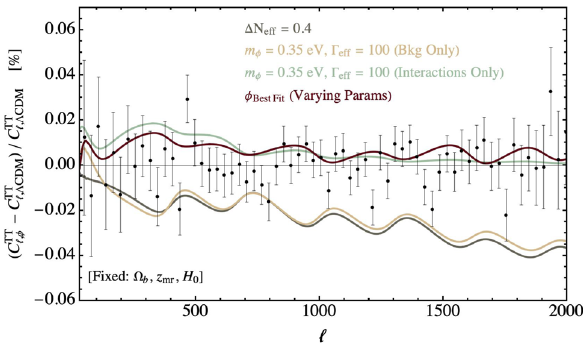
Fig. 5 Relative difference between TT power spectrum compared in various models and that of (cid:3) CDM, shown in comparison with Planck 2018 residuals. Models shown include (i) constant (cid:2) N eff = 0 . 4 (grey), ≡ 0 . 37), N = 2, (ii)primordialmajoronwith T d = 50MeV( (cid:2) N BBN int eff m φ = 0 . 35eVand (cid:15) eff = 10 2 ,includingonlythebackground(yellow), only the damping of free streaming (green), and the best-fit point (red). Withtheexceptionof φ BestFit ,allmodelsuse (cid:3) CDMbest-fitparameters, adjusted to ensure (cid:19) b , z mr , and H 0 are constant. Notice that the best = − 4 . 5, implying a better fit fit majoron cosmology has χ 2 φ − χ 2 (cid:3) CDM than (cid:3) CDM to Planck+BAO